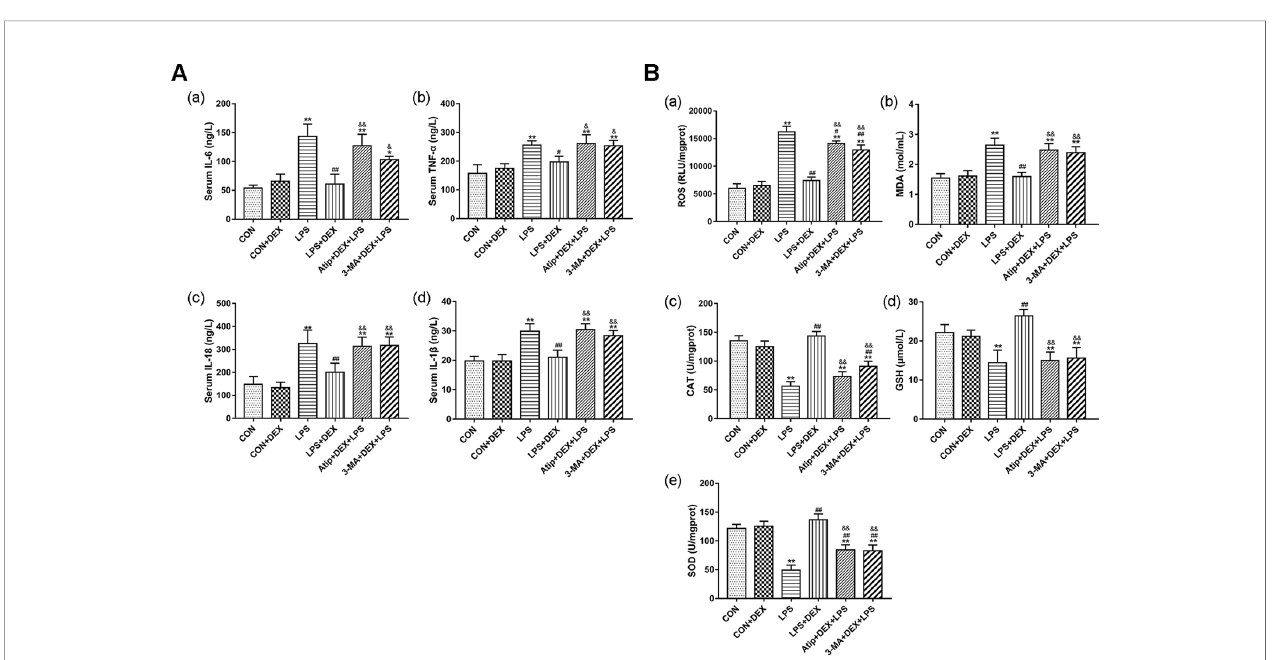
FIGURE 3 | DEX reduced in fl ammation and oxidative stress in LPS-induced AKI. (A) The content of in fl ammatory cytokines in serum, including IL-6 (a), TNF- a (b), IL-18 (c), IL-1 b (d). (B) The content of ROS (a); the concentration of MDA (b); the activity of CAT (c); the content of GSH (d); the activity of SOD (e). Data are expressed as mean ± SEM (n = 6). *p < 0.05, **p < 0.01 versus CON group. #p < 0.5, ##p < 0.01 versus LPS group. &p < 0.05, &&p < 0.01 versus DEX + LPS